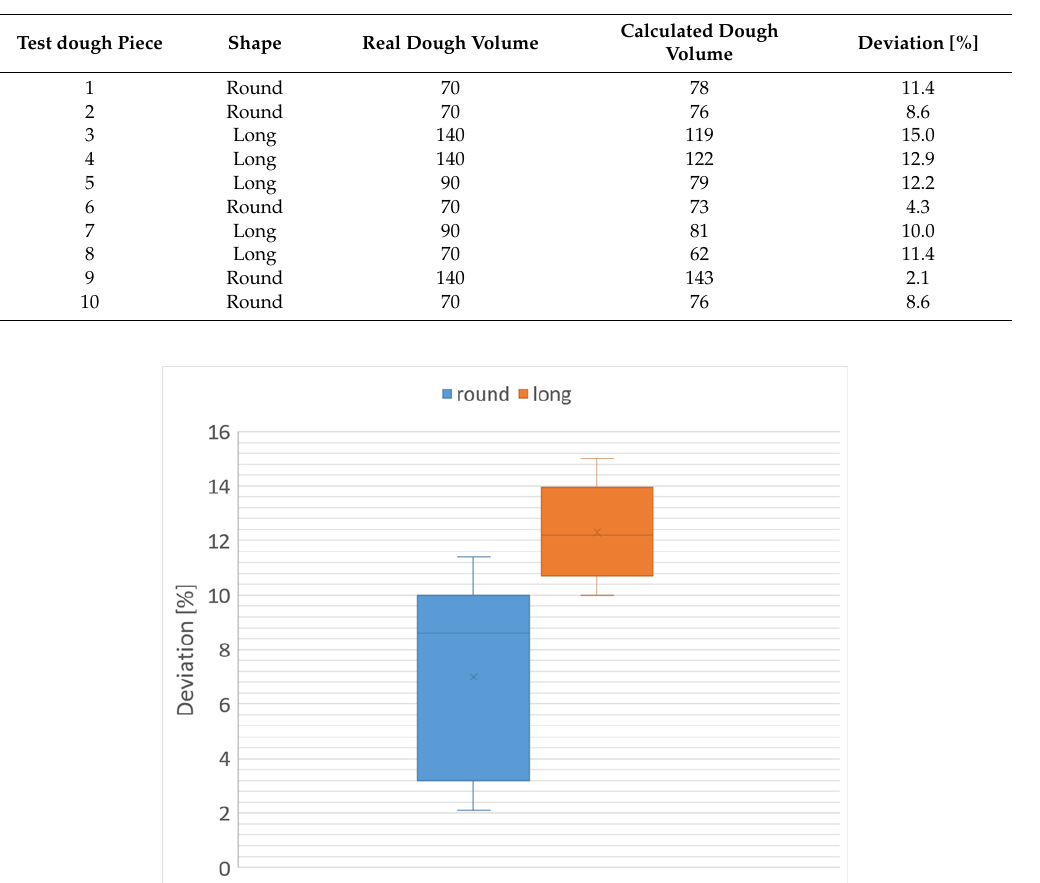
Figure 10. Processing steps: a) Measured topography point cloud of the fermentation chamber inside; b) Segmented dough pieces; c) Model-fitted dough pieces. Proper segmentation and plausible model-fitting of the points by means of superellipsoids could be seen. The metallic interior surface of the fermentation chamber does not disturb the measurement because the light scatters and bounces in uncontrollable directions. This fact improves the function of the segmentation neural network because of the more precise point cloud structure. The processing time results from the sum of the segmentation and the model fitting time. Currently, the former amounts to less than one second due to the use of an NVIDIA GeForce GTX 1060 GPU. The latter